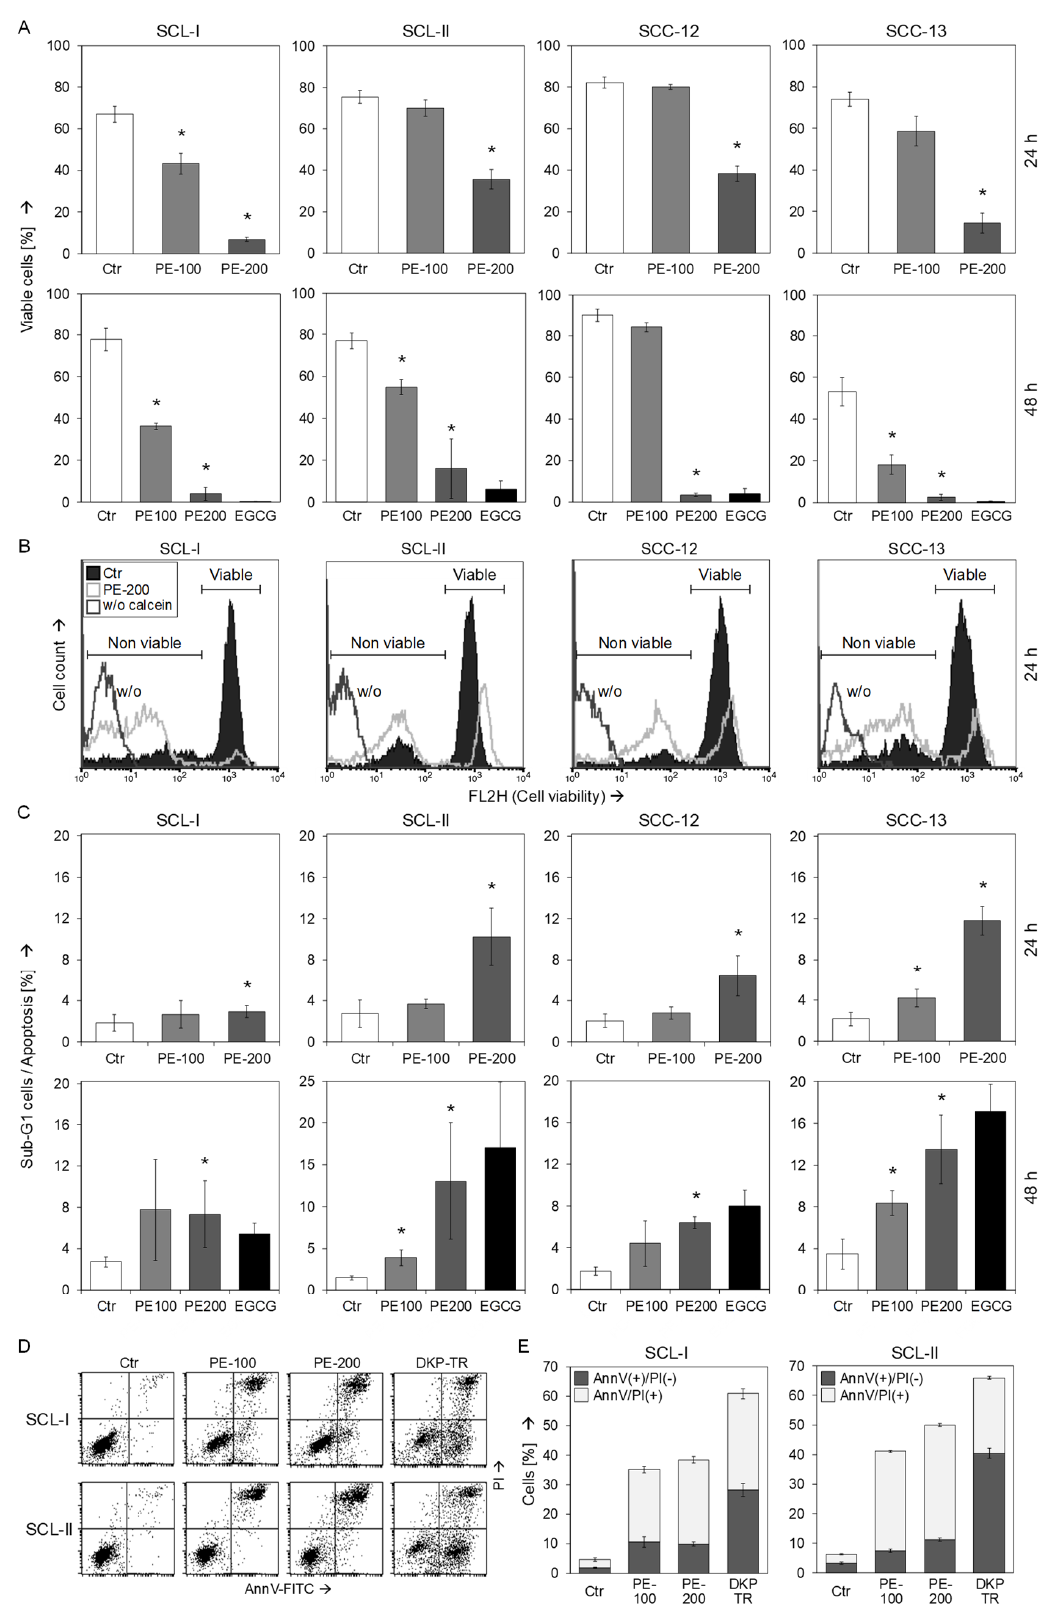
Figure 2. Reduced cell viability by PE. ( A – C ) SCL ‐ I, SCL ‐ II, SCC ‐ 12, and SCC ‐ 13 were seeded in 24 ‐ well plates and were treated with PE (100, 200 μ g/mL) for 24 h and 48 h, respectively. For control, cells were also treated with 100 μ g EGCG for 48 h. ( A ) Cell viability was determined by calcein ‐ AM staining and flow cytometry. Values represent the percentage of cells with high calcein staining (=